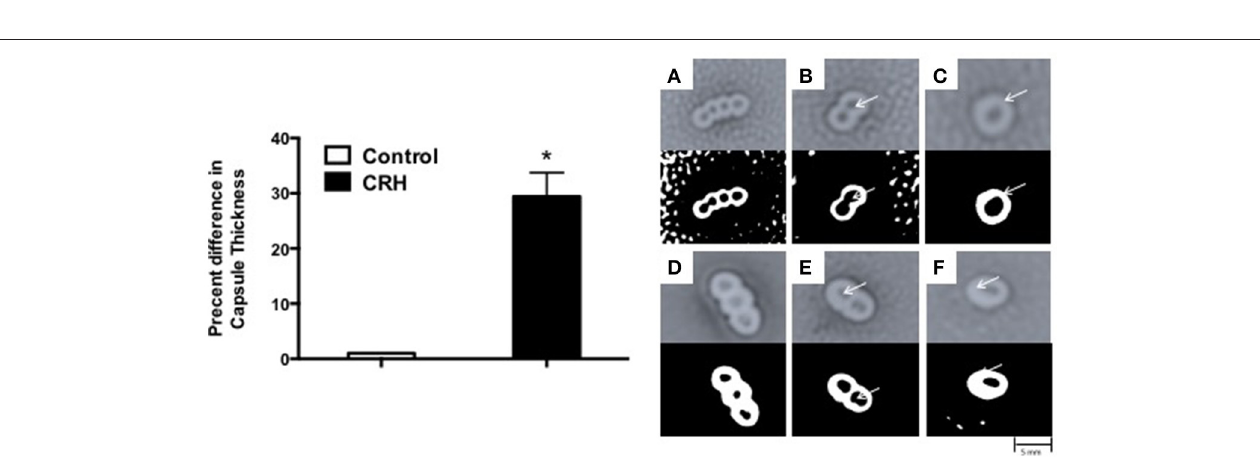
FIGURE 2 | Capsular thickness is increased by CRH. Serotype 1 pneumococcal strain (10 8 organisms) was grown in the presence or absence of CRH (4.0 × 10 − 4 mM/ µ l) for 5 h. Capsular thickness was determined by calculating the absolute difference between total diameter of outer and inner capsular membranes. Bars represent the mean ( n = 9) ± standard deviation in the percent difference in capsular diameters of CRH-treated organisms compared to control. Asterisks (*) indicate significant ( P ≤ 0.05) differences between experimental and control groups (Left). 100X magnified images of untreated (A–C) and CRH-treated (D–F) S. pneumoniae are shown in right panel. Lower panels represent corresponding high contrast color images highlighting capsule and diplonuclei denoted by